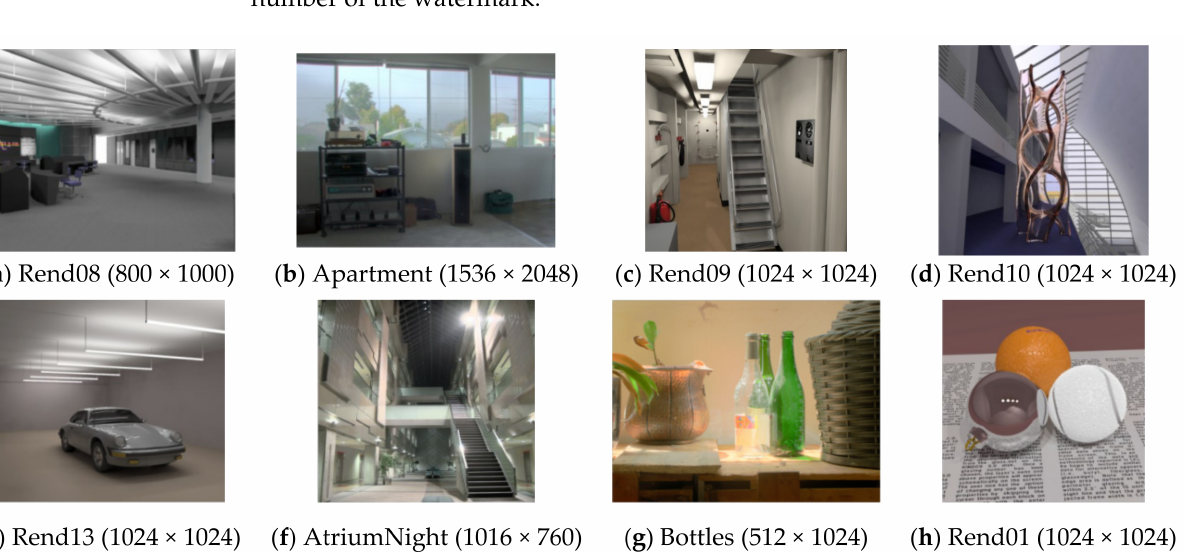
Figure 5. Original HDR